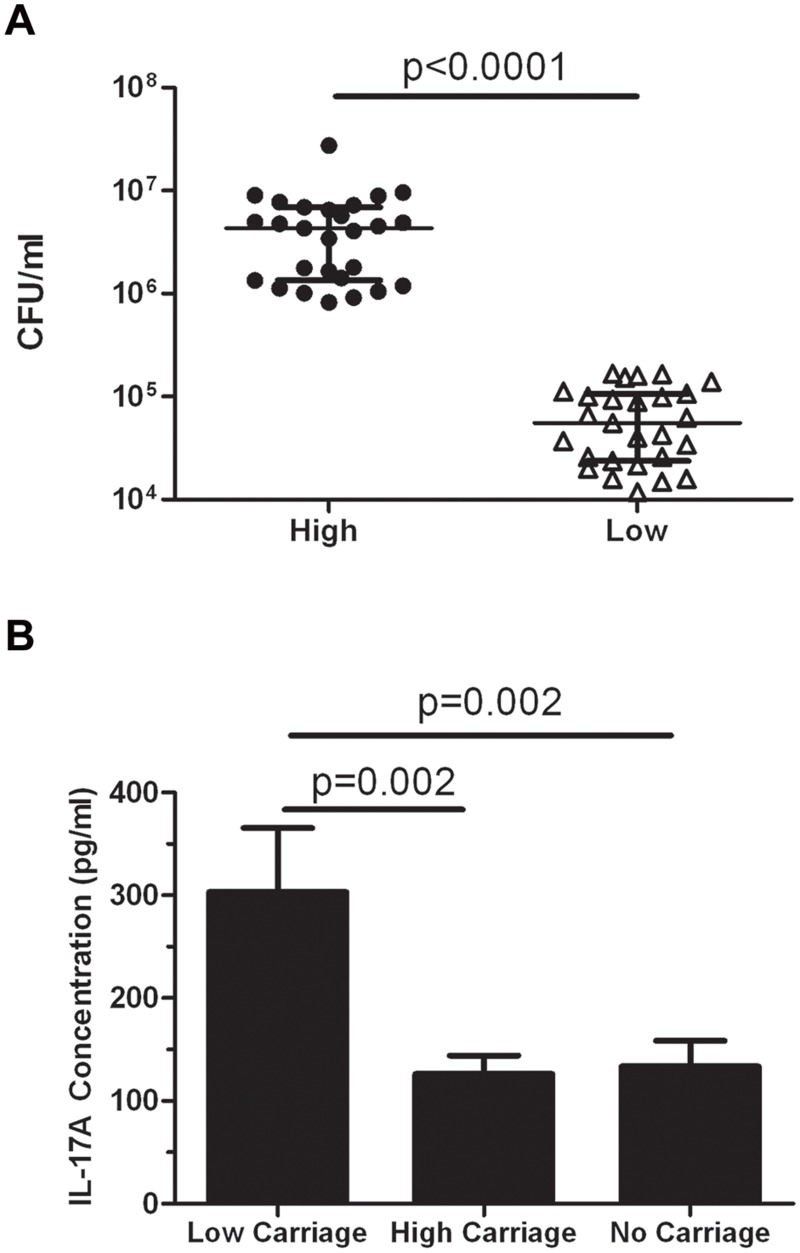
IL-17A levels in children with high and low pneumococcal carriage densities.(A) Carriage density >8.21 x 105 CFU/ml was defined as a ‘high’ carrier and <1.67 x 105 CFU/ml was defined as a ‘low’ carrier. Scatter plots show the median ± interquartile range for children with high carriage (N = 27) and low carriage (N = 27). Statistical comparisons were done using Mann-Whitney U test. (B) IL-17A levels in PBMC supernatants from children in Fiji with high (N = 27) or low (N = 27) pneumococcal carriage densities as well as children that did not carry pneumococcus (N = 29). Bars represent mean ± SEM. Statistical comparisons were done using an unpaired Student’s t test.